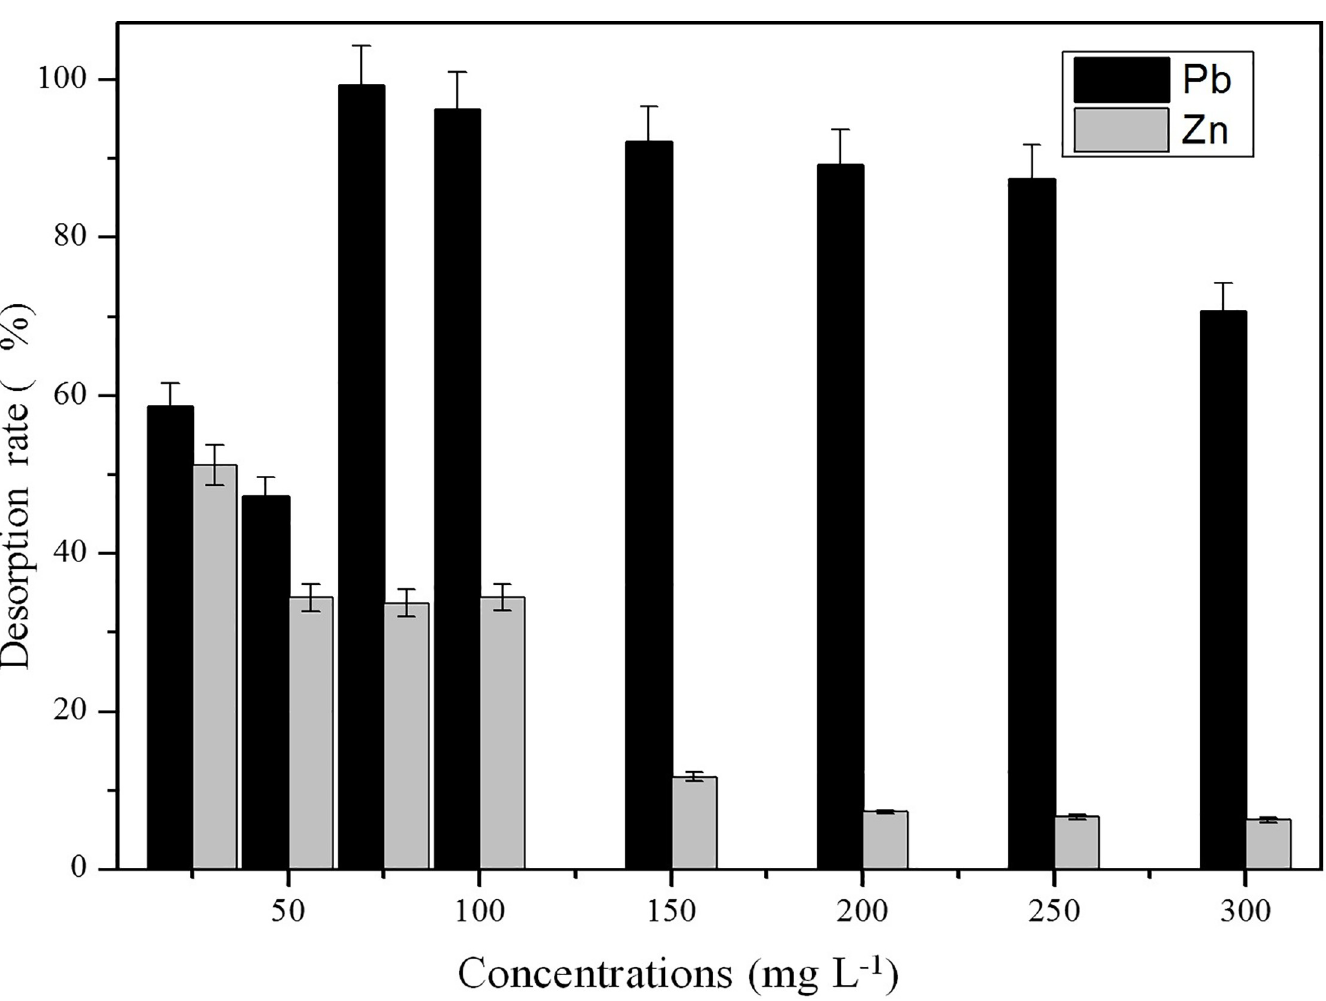
Fig 9. Desorption efficiency at different heavy metal concentrations. Initial biosorption conditions: initial pH = 4, absorption time 7 days, initial biomass does 2mL L -1 , temperature 30˚C.